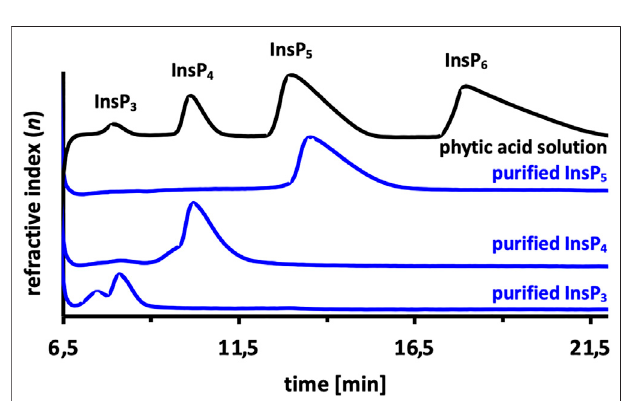
FIGURE 2 | Puri fi ed inositol phosphate (InsP) standards using semi- preparativeHPLC.Phytate(InsP 6 )washydrolyzedbyEcphy,andthereaction stopped accordingly to purify the target inositol-phosphates (InsP 3 , InsP 4 , InsP 5